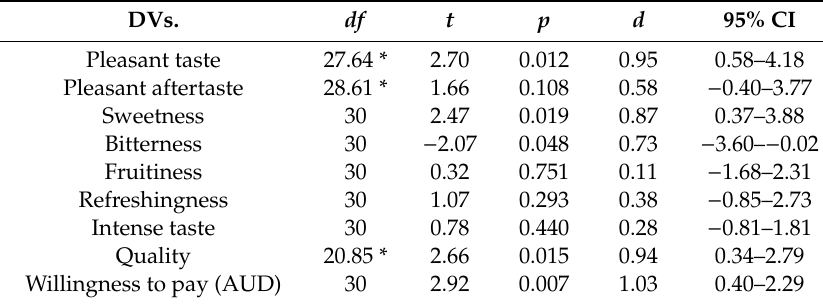
Table 2. Independent-samples t -tests for beer flavor characteristics assessing di ff erences between the joviality and sadness groups. We subjected our analyses to Holm–Bonferroni corrections and, as there were nine tests, we applied a stringent critical p -value of 0.006 (i.e., 0.05 / 9). DVs. df t p d 95% CI Pleasant taste 27.64 *